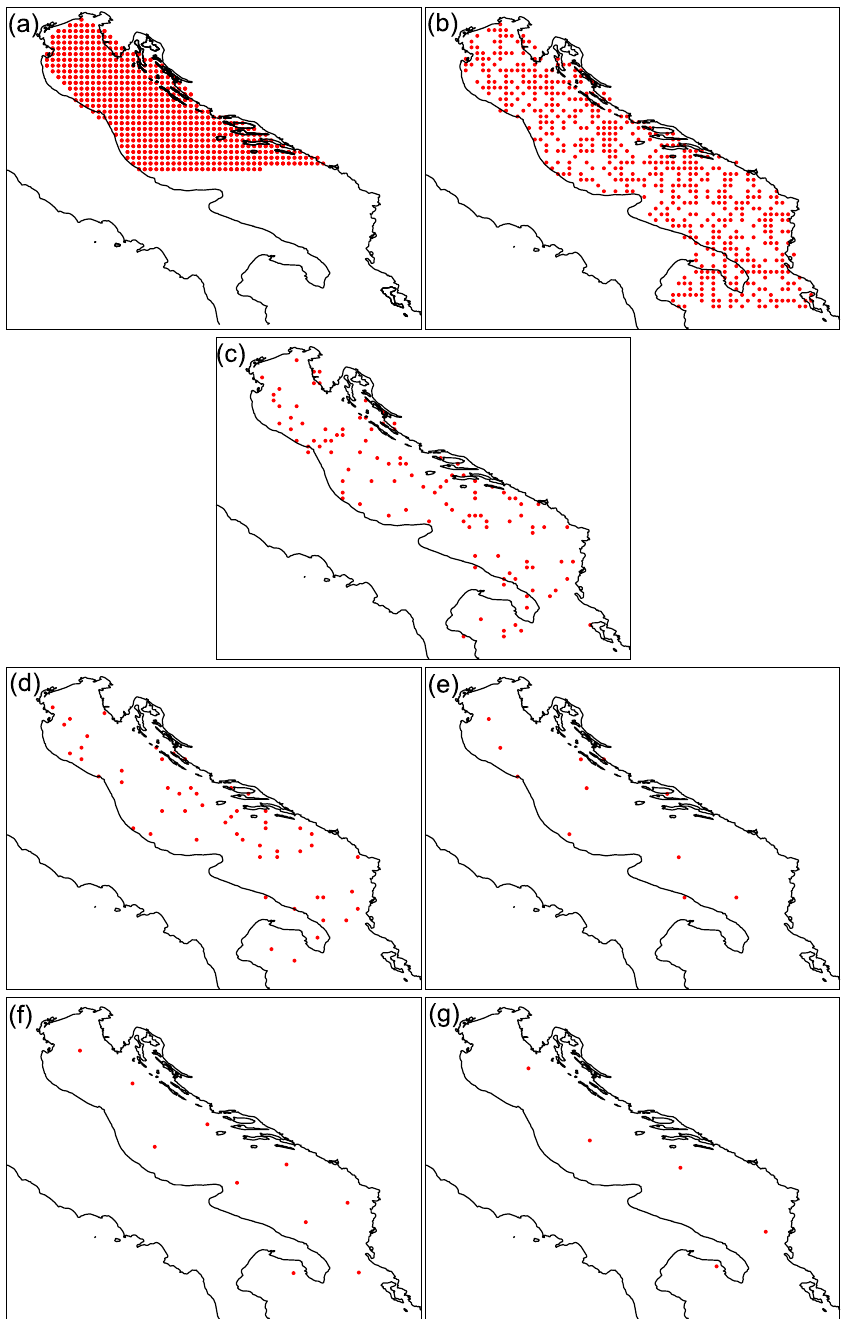
Figure 3. Sampling scenarios used in experiments ( a – g ): ( a ) 50% samples selected in successive order. ( b ) 50% samples selected randomly. ( c ) 10% samples selected randomly. ( d ) 5% samples selected randomly. ( e ) 1% samples selected randomly. ( f ) 10 samples selected by the k-means algorithm. ( g ) 5 samples selected by the k-means